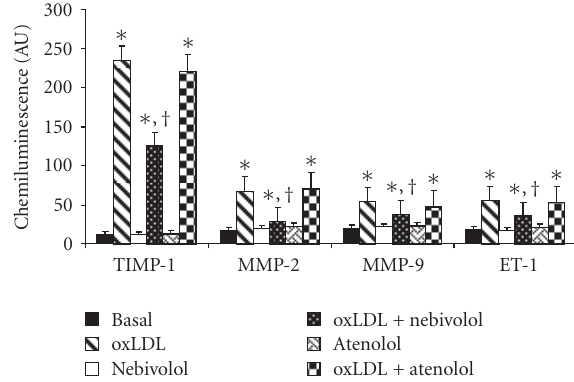
Figure 3: E ff ect of nebivolol and atenolol on RNA expression of endothelin-1 (ET-1), metalloproteinases (MMP-2, MMP-9) and protease inhibitor (TIMP-1) induced by oxidative stress in human umbilical vein endothelial cells (HUVECs). HUVECs were incubated with nebivolol or atenolol (10 μ M) for 24 hours at 37 ◦ C; oxidative stress was induced by the addition of oxidized (ox)LDL (50 μ g proteinmL − 1 ). ∗ P < . 001 versus control; † P < . 01 versus ox- LDL. AU = arbitrary units. Data are expressed as means ± SD of 6 di ff erent